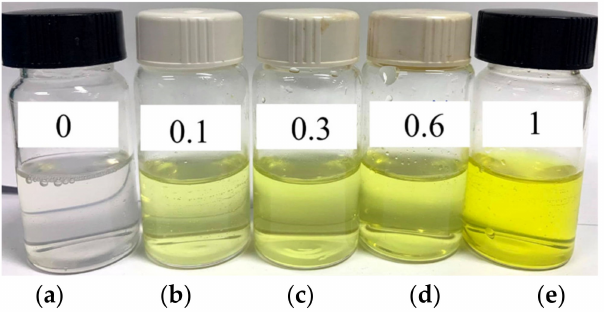
Figure 2. Pictures of blank NBSCh micellar solution ( a ) and NBSCh micellar solutions containing CL at different concentrations ( b ) 0.1, ( c ) 0.3, ( d ) 0.6, ( e ) 1.0